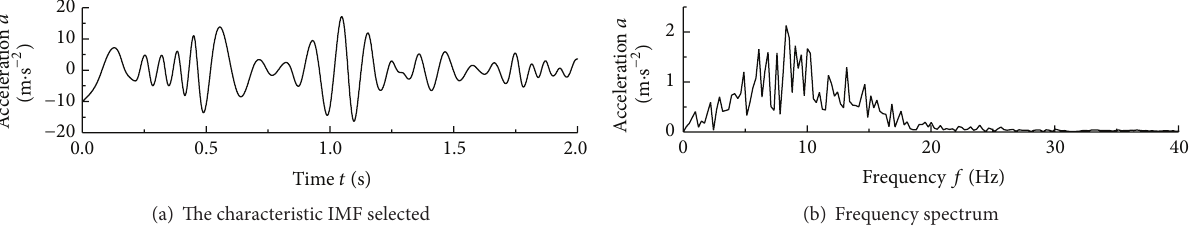
Figure 15: Analysis results of the signal presented in Figure 13 by EEMD: (a) the characteristic IMF and (b) FFT spectrum.